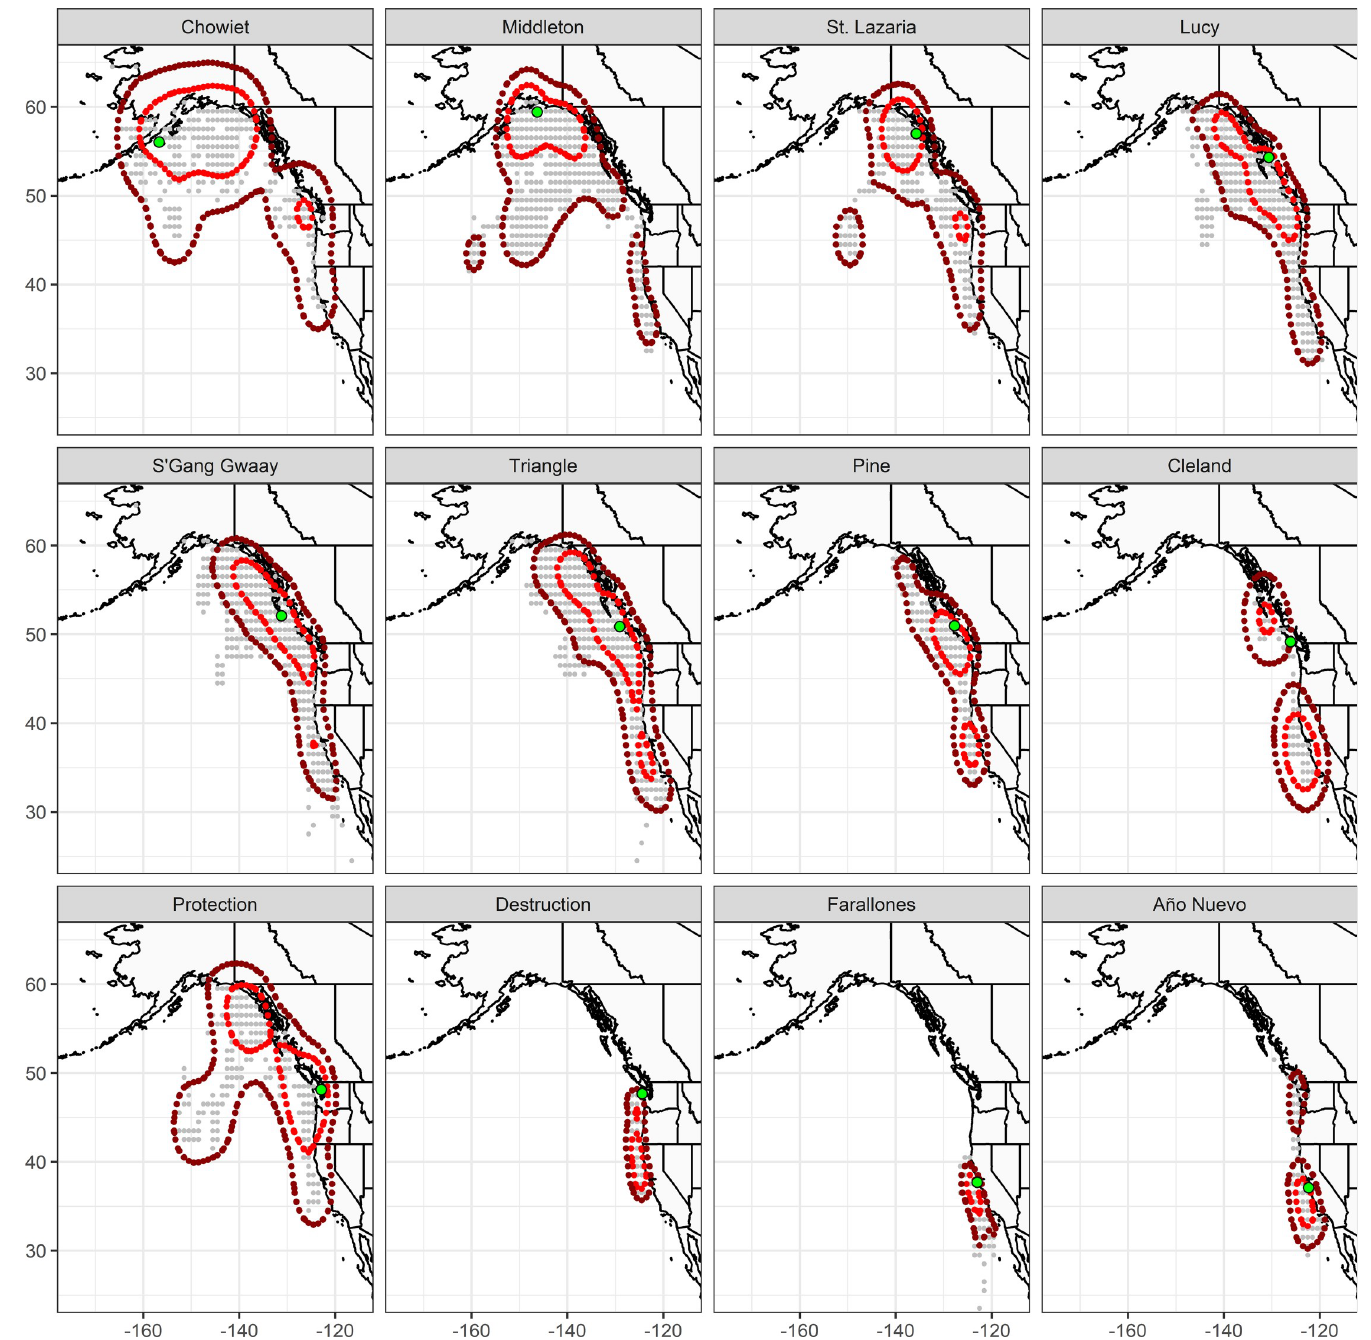
Fig 5. Home ranges of rhinoceros auklets during the wintering period (Nov-Feb) from breeding colonies on the Pacific coast of North America, 2014 to 2016. Light green dots indicate the locations of breeding colonies. Light gray marks are point locations on a 1˚ × 1˚ grid, as derived from TwilightFree geolocation analyses of light recorders deployed on all birds at each colony. Red polygons indicate the 50% Utilization Distribution (‘core wintering area’), and dark red polygons indicate the 90% Utilization Distribution.